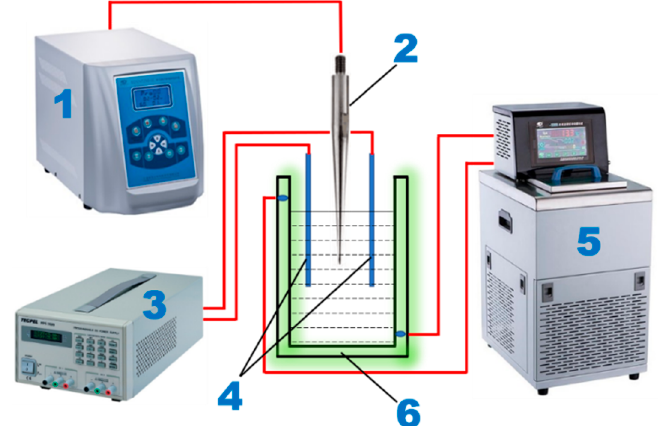
Figure 1. Experimental device 1—ultrasonic cell pulverizer, 2—ultrasonic horn, 3—DC power supply, 4—platinum sheet electrode, 5—low temperature and constant temperature distiller’s grains, 6—jacket beaker reactor.